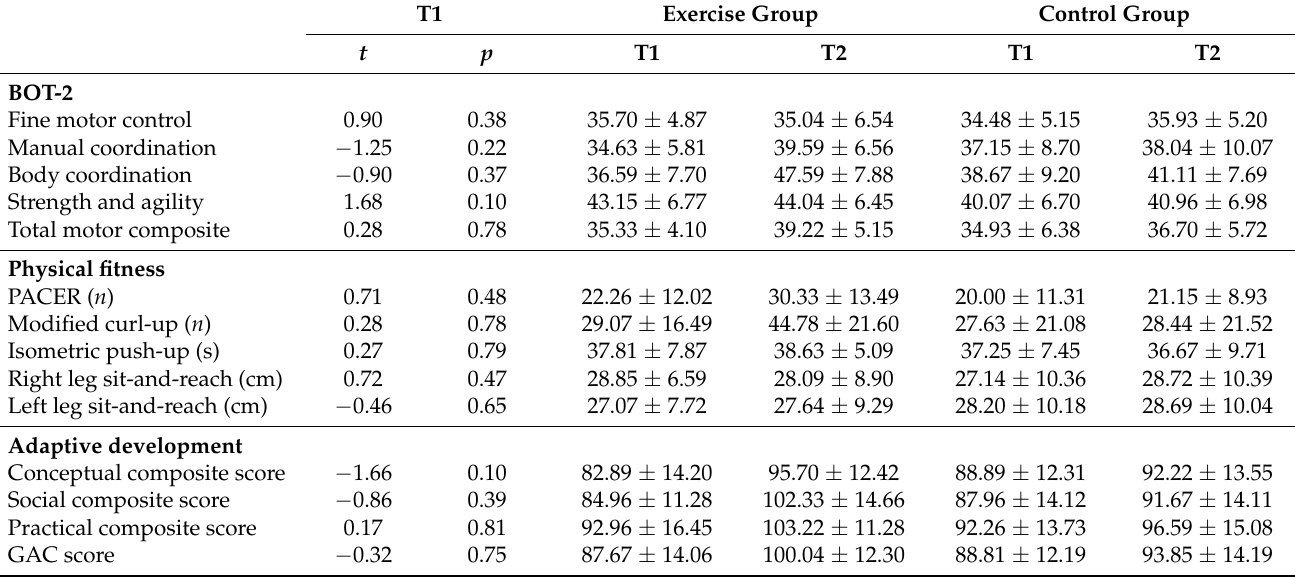
Table 3. Changes in motor proficiency, physical fitness, and adaptive development of the participants following 12 weeks of intervention. T1 Exercise Group Control Group